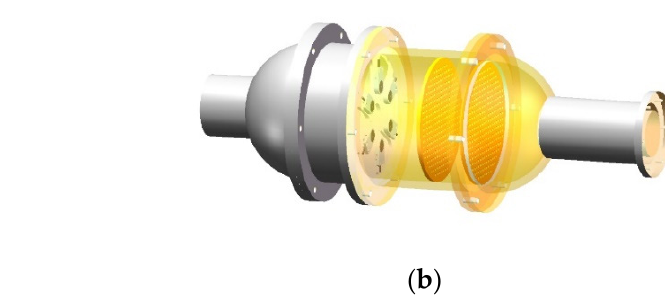
Figure 5. Dimensional design of the air inlet.